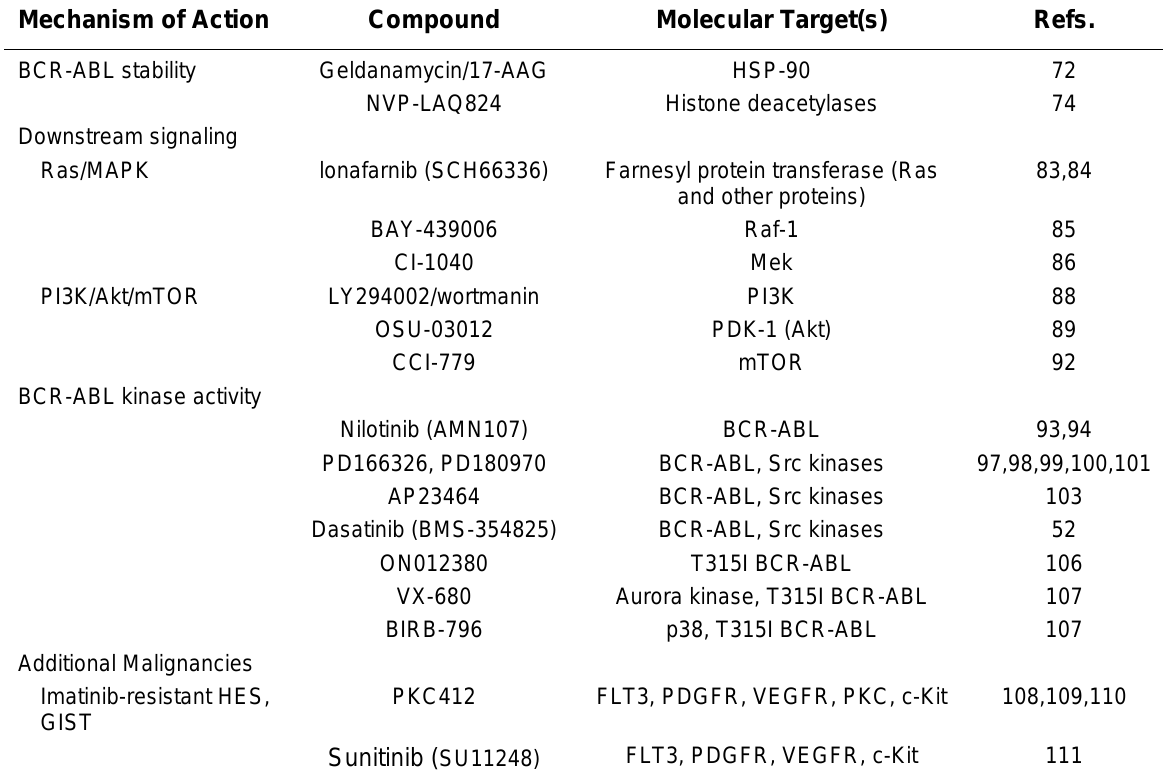
Summary of Compounds Utilized to Target Imatinib